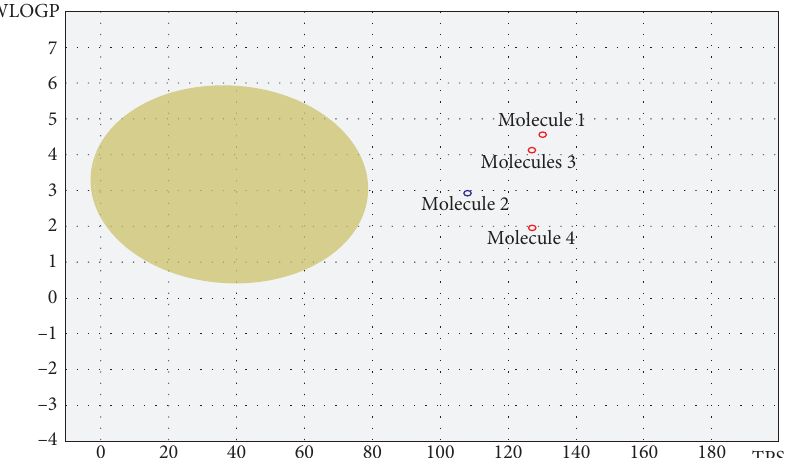
Figure 8: Image showing the bioavailability radars of the 4 final drug candidates. ZINC000254823011, ZINC000013627512, and ZINC000009418994 are not orally bioavailable because their red line radars do not lie within the pink region. ZINC000072307130 is orally bioavailable; its red line radar falls within the pink region.